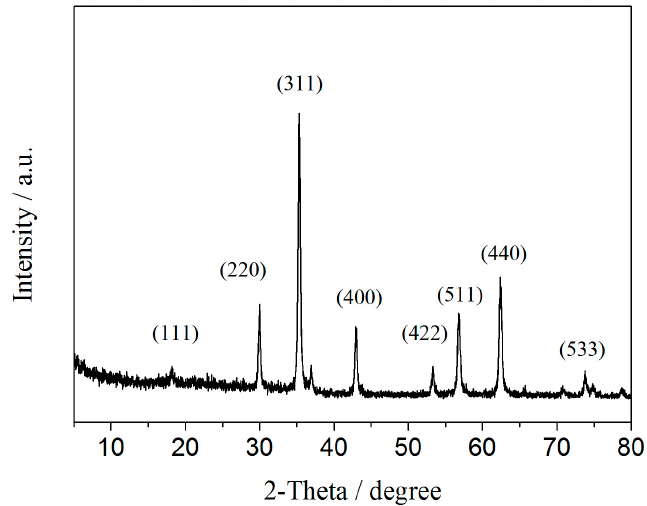
Figure 2. The XRD pattern of MN.